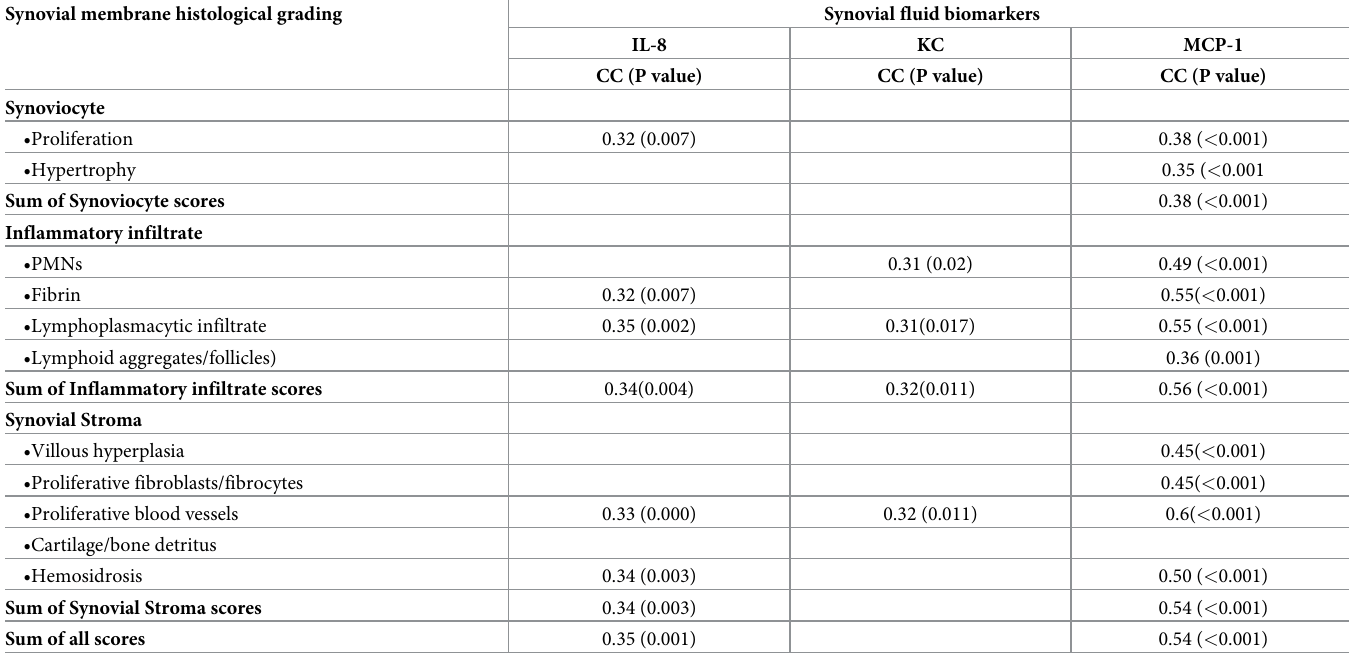
Table 5. Correlation between synovial fluid biomarkers (i.e., IL-8, KC, MCP-1) and histopathological grade of biopsied synovial membrane. Synovial membrane histological